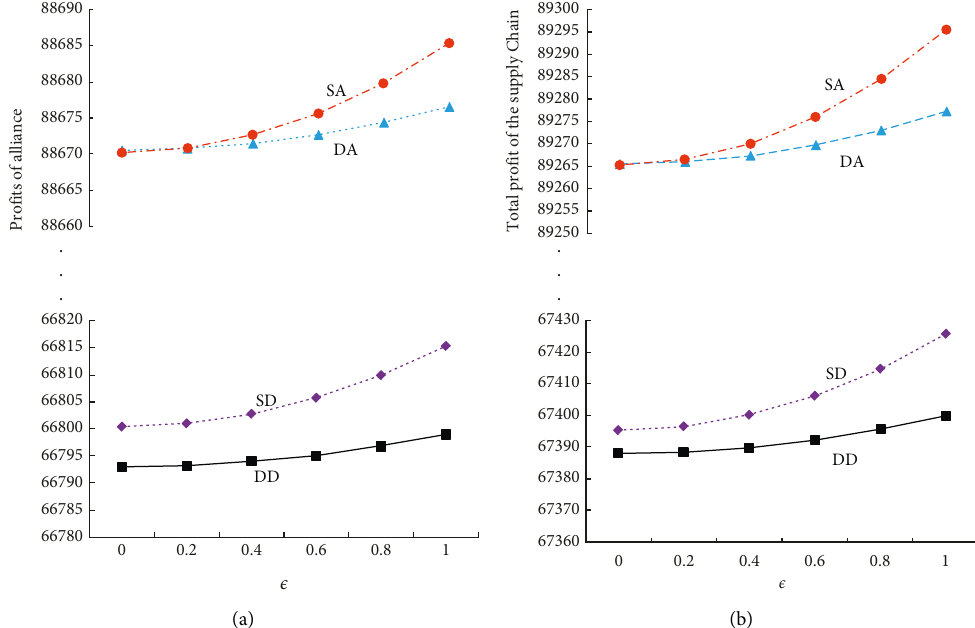
Figure 5: The effect of ϵ on alliance profits and the total profit (a) the effect on alliance profit of the manufacturer and the retailer (b) the effect on the total profit of the supply chain.